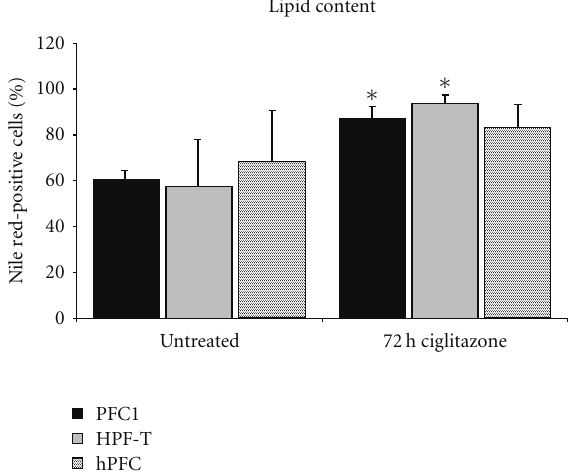
Figure 2: Lipid content evaluated by nile red binding. The figure shows the e ff ect of 72 h of ciglitazone treatment on human pan- creatic fibroblastoid cells (hPFCs, hatched columns), transformed hPFCs (HPF-T grey columns), and rat PFC1 cells (black columns) in comparison. Nile red binding to cells was evaluated by flow cytometry and calculated as % of nile red-positive cells. Ciglitazone- induced nile red binding in all cells tested, and hPFC showed a high variation of lipid content in untreated cells with the mean higher than any other cell line tested, but with P = 0.053, the rise in lipid content was not significant. (Depicted are means plus standard deviation, ∗ significant versus untreated, n ≥